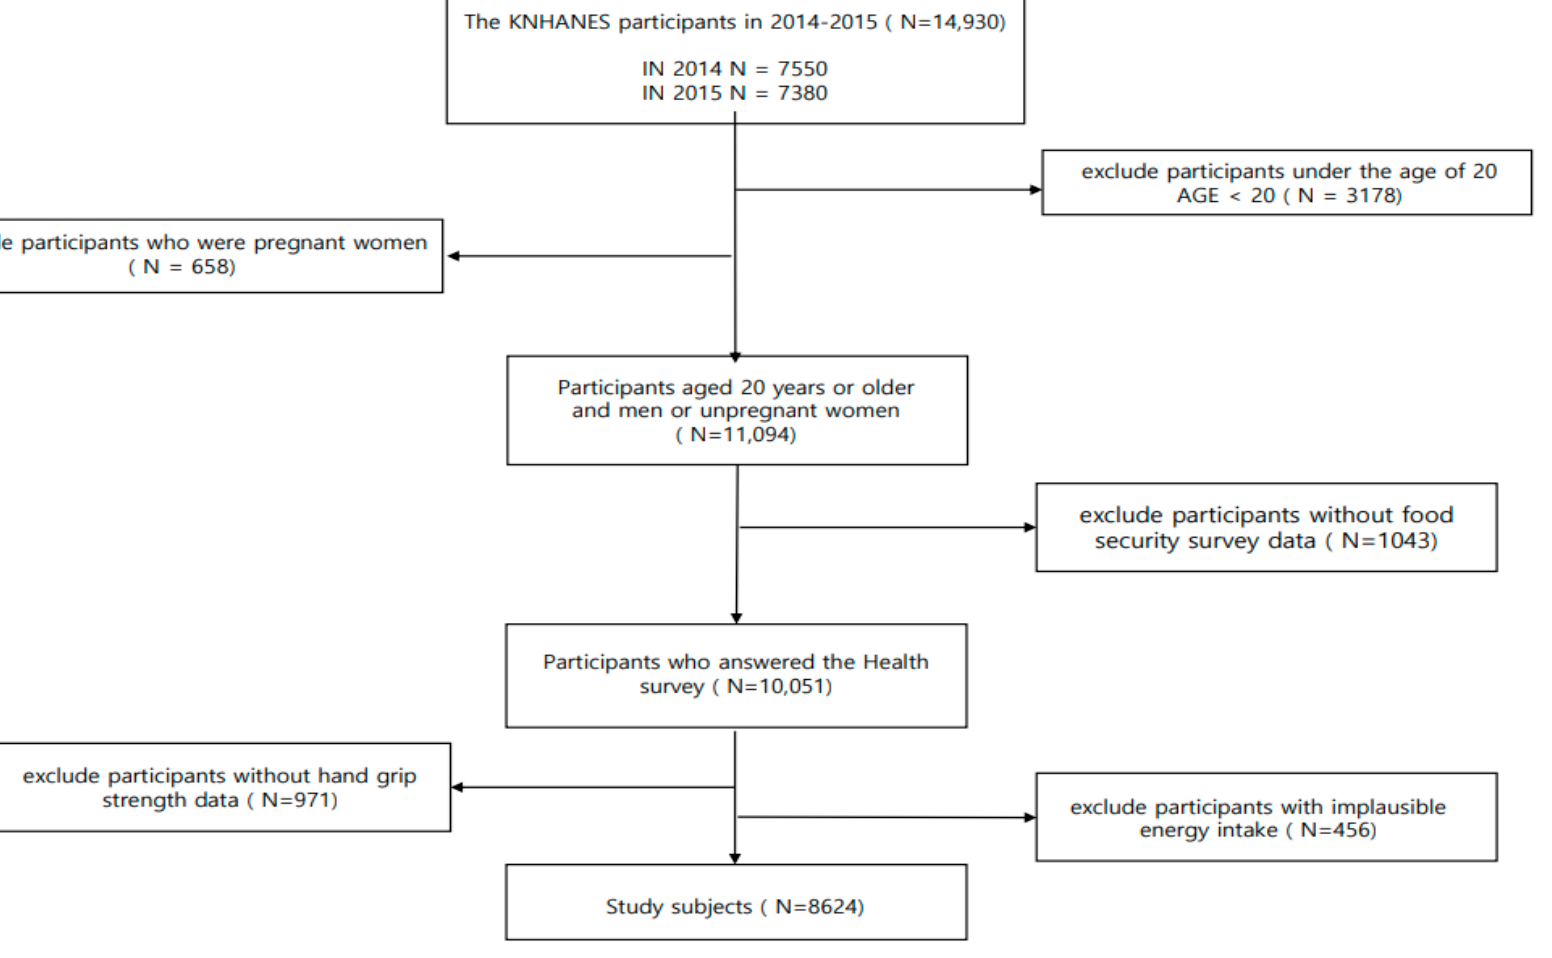
Figure 1. Flow diagram of the study population selection.